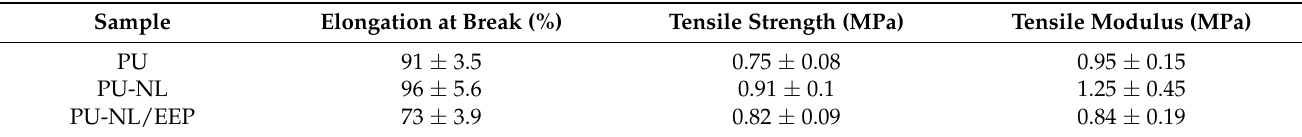
Table 1. Mechanical properties of prepared samples.